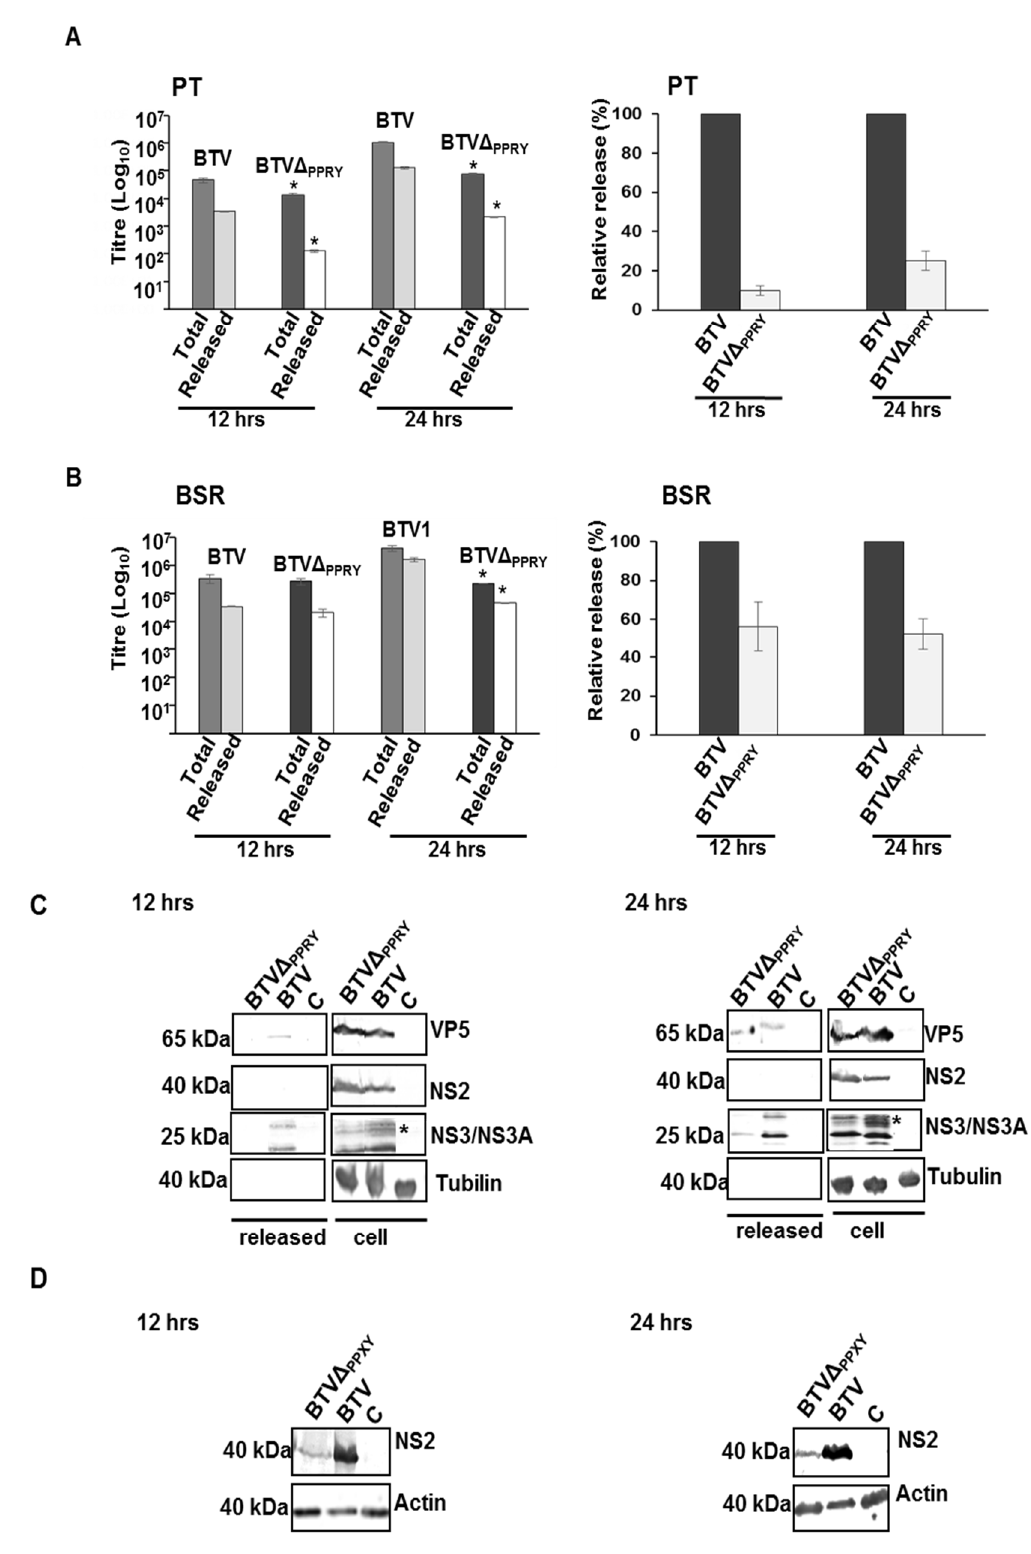
Figure 8. Release of BTV influenced by mutation of PPRY domain. The total and cell free titres in PT ( A , left) and BSRs ( B , left) were plotted on a logarithmic scale. The titre of each fraction was determined by plaque assay. ( A , B , right) The relative release was calculated